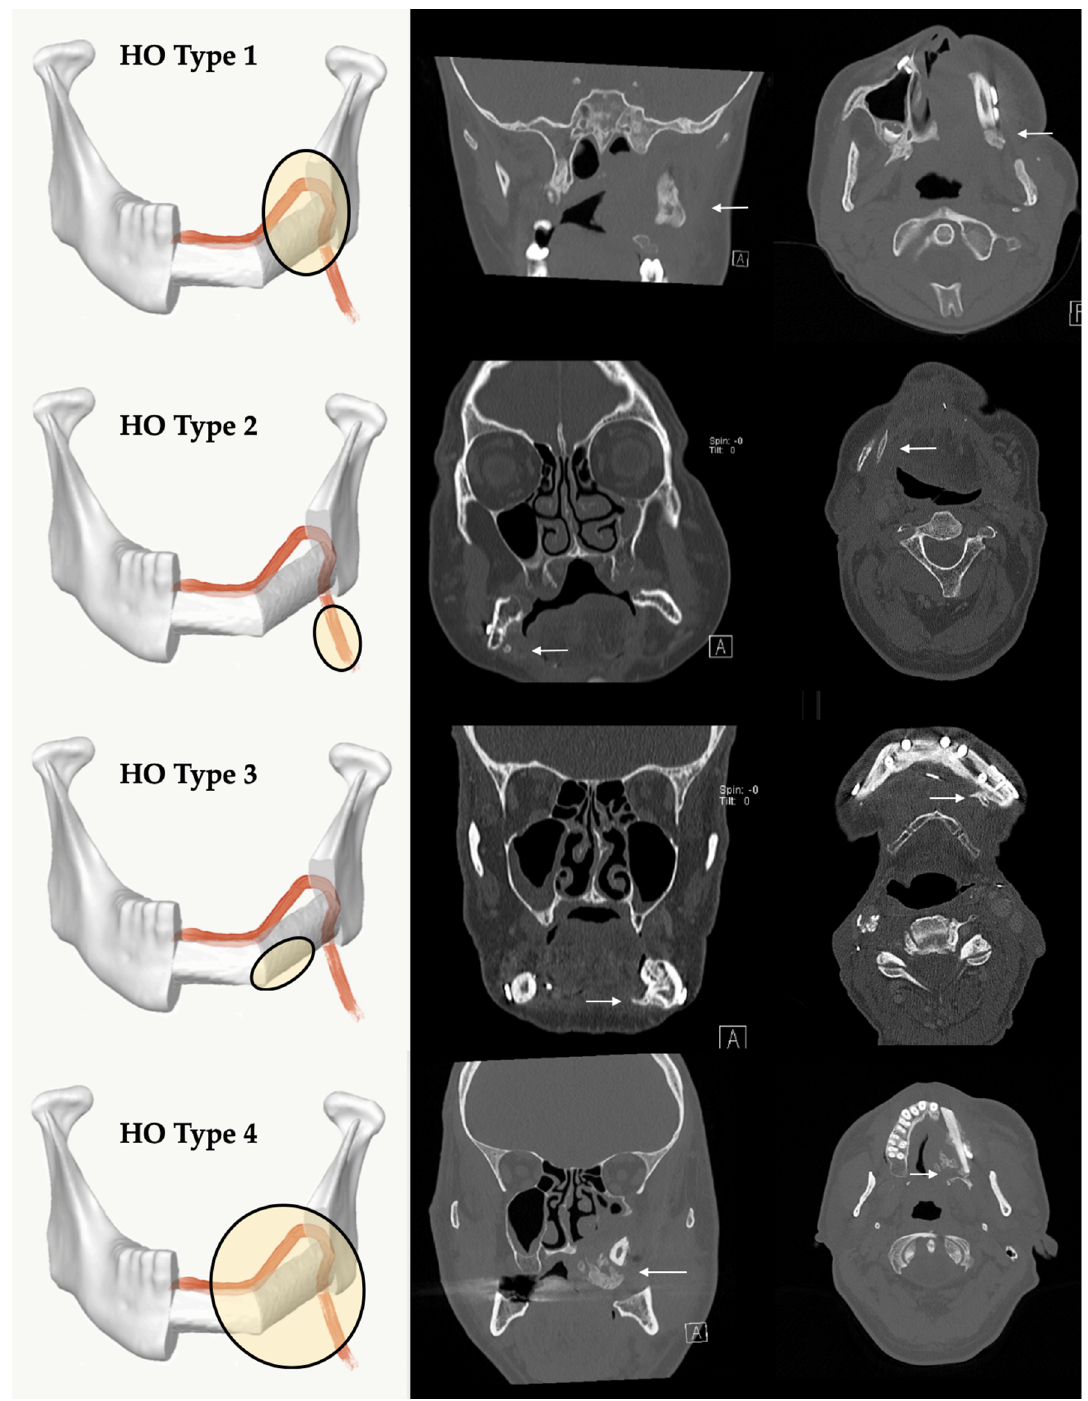
Figure 1. Classification of different radiological types of heterotopic ossification (HO): Type 1 = HO at the transition zone from fibula graft to vascular pedicle, Type 2 = HO isolated at the pedicle without contact to the fibula, Type 3 = HO appears isolated at the periosseous tissue without involvement of the vascular pedicle, Type 4 = a combination with ossification of the pedicle and periosseous tissue. The white arrows mark region of interest. A= Anterior.